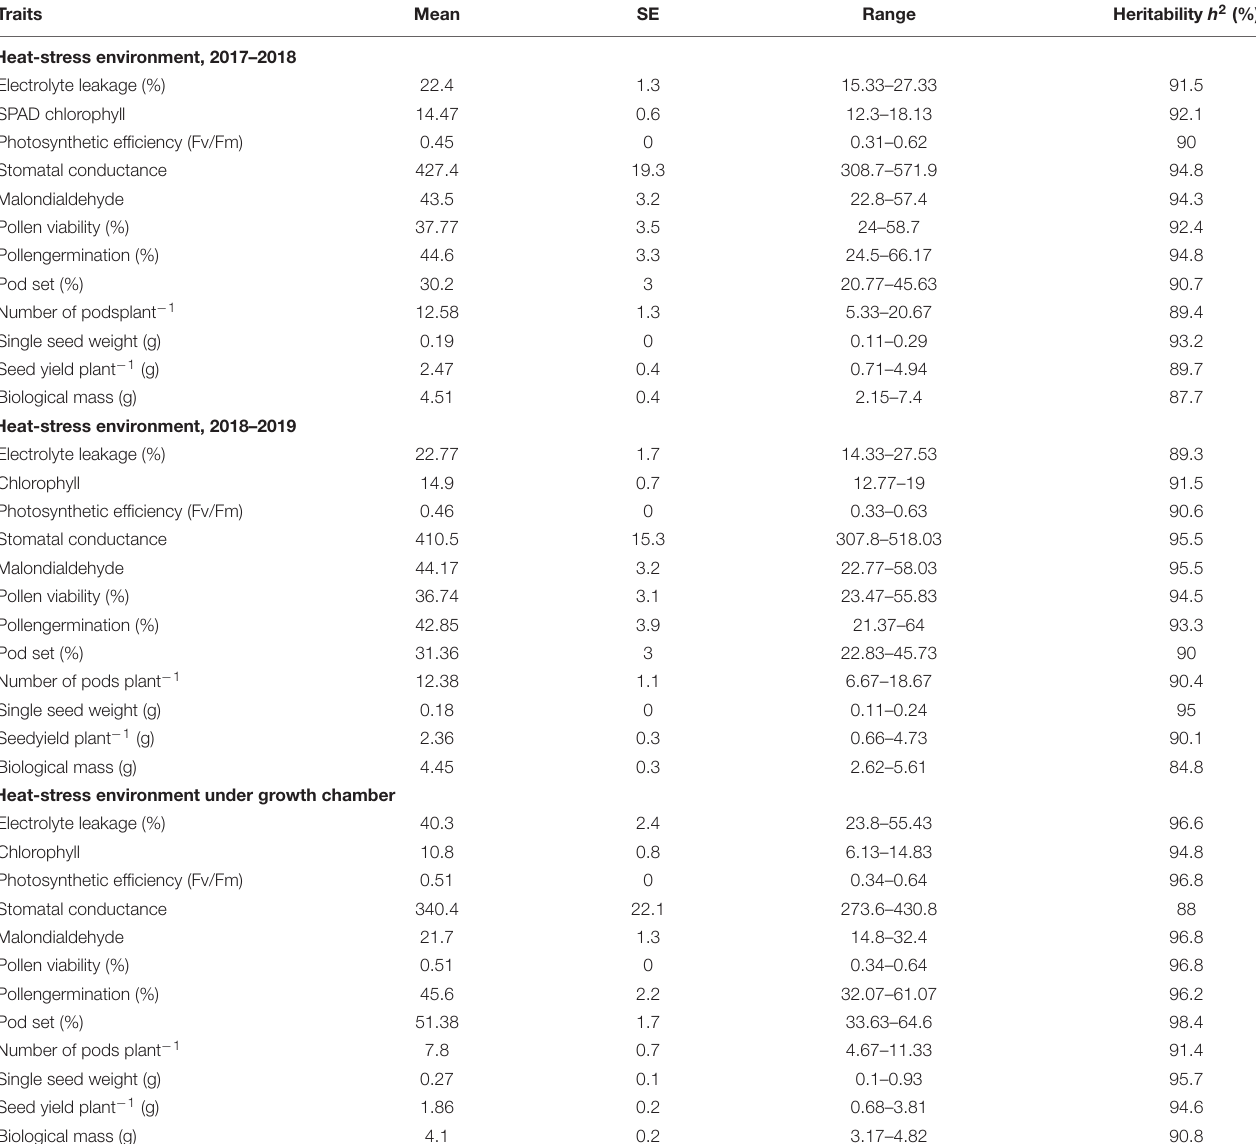
TABLE 2 | General statistics of various traits in chickpea genotypes under heat stress environment. Traits Mean SE Range Heritability h 2 (%)